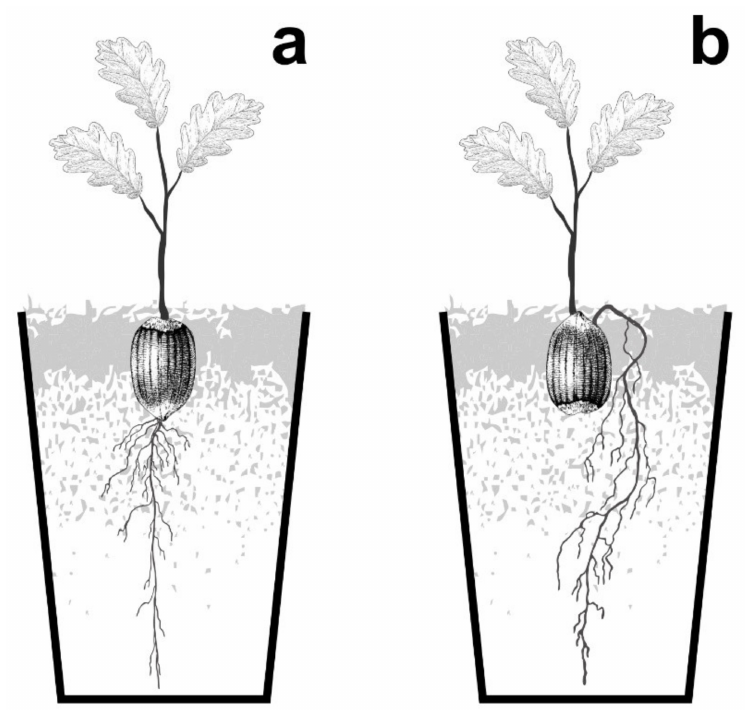
Figure 3. Regular ( a ) and offered ( b ) methods of acorn planting.